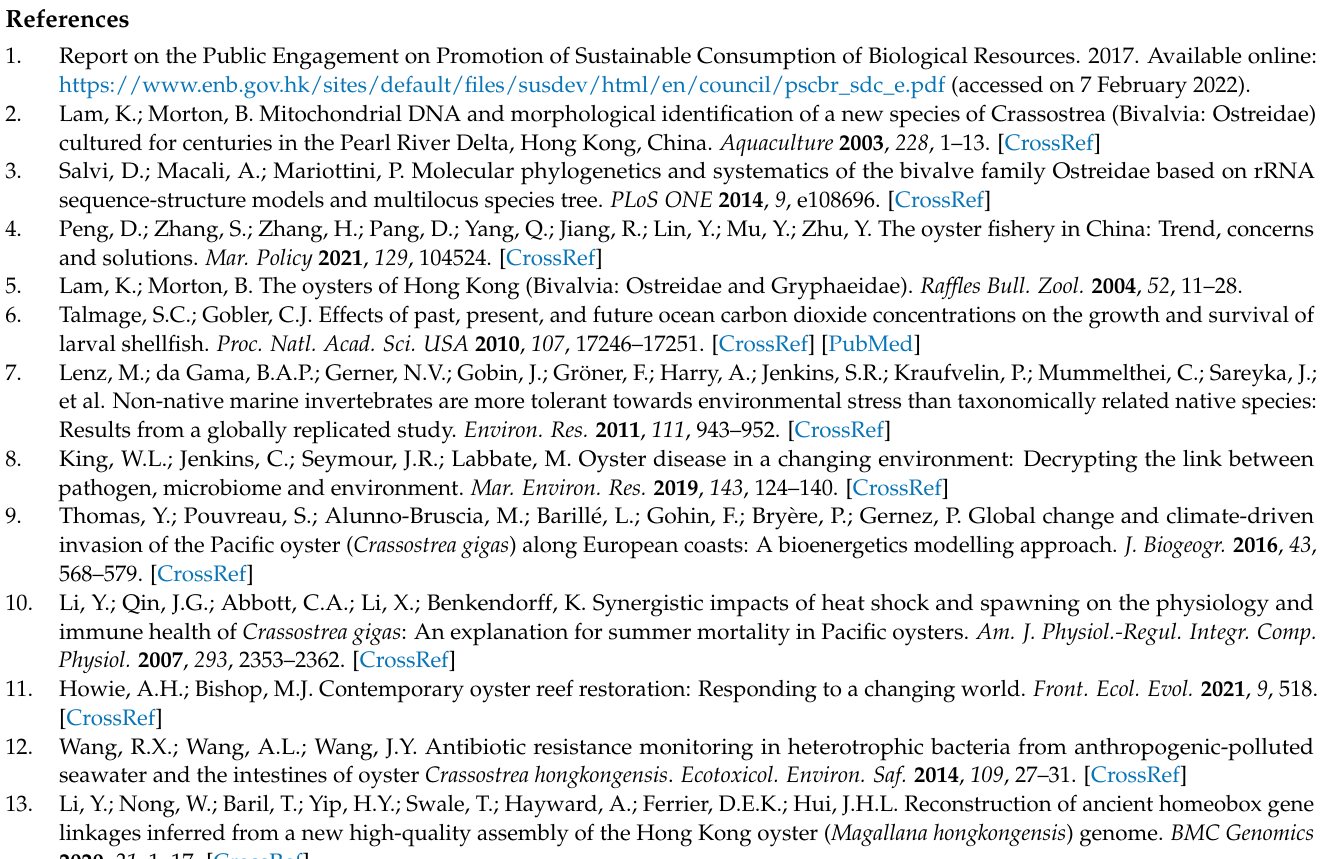
S1–S13. Table S1: GPS coordinates of oyster samples; Table S2: Heat shock proteins annotated in M. hongkongensis ; Table S3: Primer sequences for SNP validation of ScQ1DuM_12504:36310998 in 3 individuals collected at B7; Table S4: Genome sequencing data; Table S5: Transcriptome sequencing data; Table S6: SNPs and INDELs of Homeobox genes among 49 oyster samples; Table S7: SNPs and INDELs of Hsp70 genes among 49 oyster samples; Table S8: Unique SNPs and INDELs of Hsp70 genes among collection batches; Table S9: Unique SNPs and INDELs of Homeobox genes between Lantau (HKU) and Shenzhen Bay (SZB); Table S10: Unique SNPs and INDELs of Hsp70 genes between Lantau (HKU) and Shenzhen Bay (SZB); Table S11: Gene expression level under normal (25 ◦ C) and heat shock (32 ◦ C) conditions; Table S12: Alternative splicing prediction under normal (25 ◦ C) and heat shock (32 ◦ C); Table S13: OTU classification of 16S amplicons of